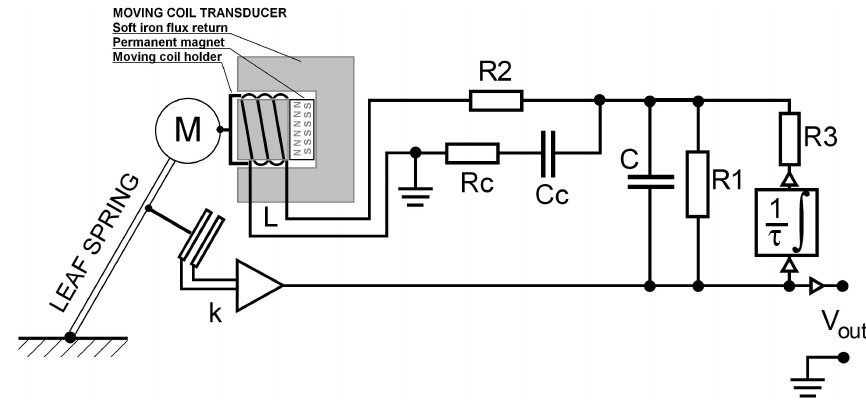
Fig. 6. A simplified scheme of the STS-2 velocity broadband seismometer (force-balanced) (per Streckeisen, 1995; Wielandt, 2002a). Mass ( M ) displacement relative to the instrument housing is detected by a capacitive displacement transducer ( K ) and converted to an electric signal that is transmitted to the feedback coil ( L ). R denote resistors, C denote capacitors. Output voltage is denoted as